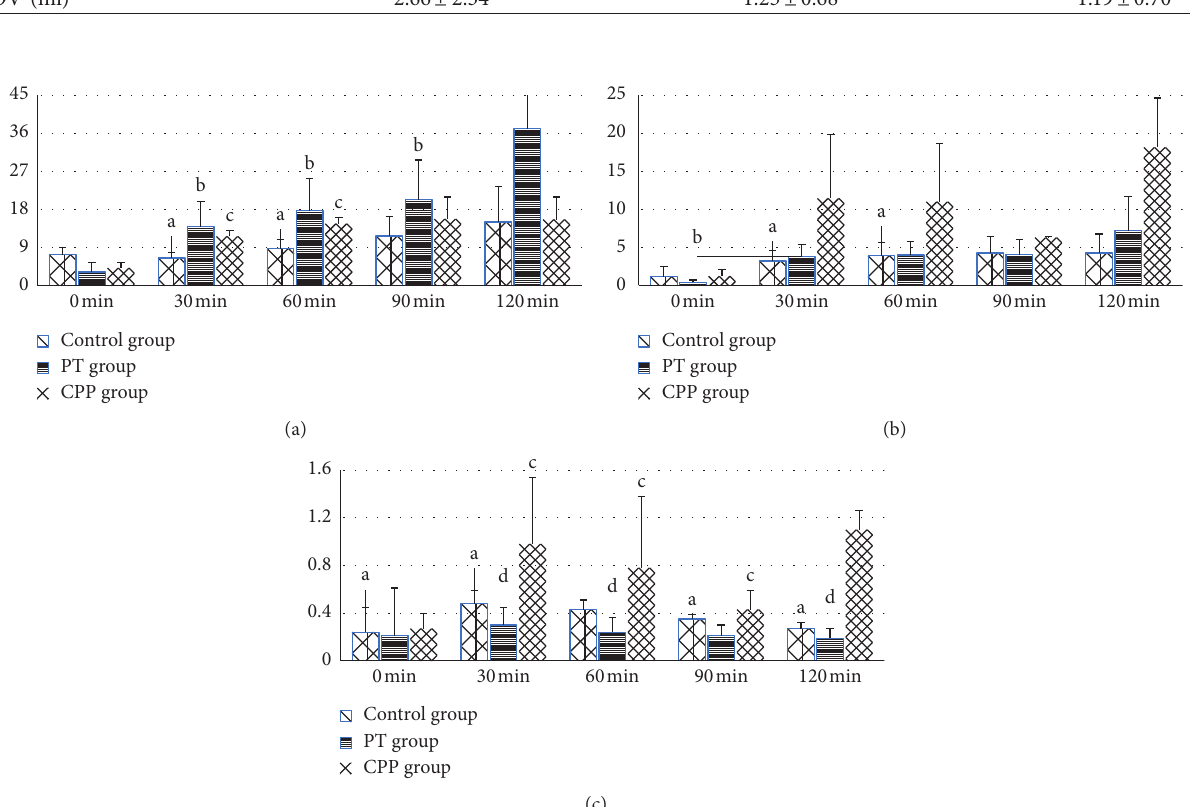
Figure 1: Comparison of the FSH and LH among the different groups. (a) Comparison of the FSH among the three groups. (b) Comparison of the LH among the three groups. (c) Comparison of the LH/FSH among the three groups. “A” represents comparison among the three groups, P < 0 . 05; “B” represents comparison between PTand controls, P < 0 . 05; “C” represents comparison between CPP and controls; “D” represents comparison between CPP and PT, P < 0 .